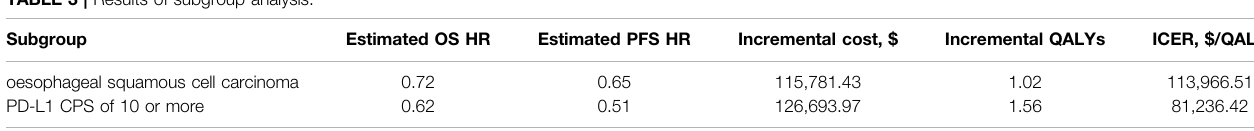
TABLE 3 | Results of subgroup